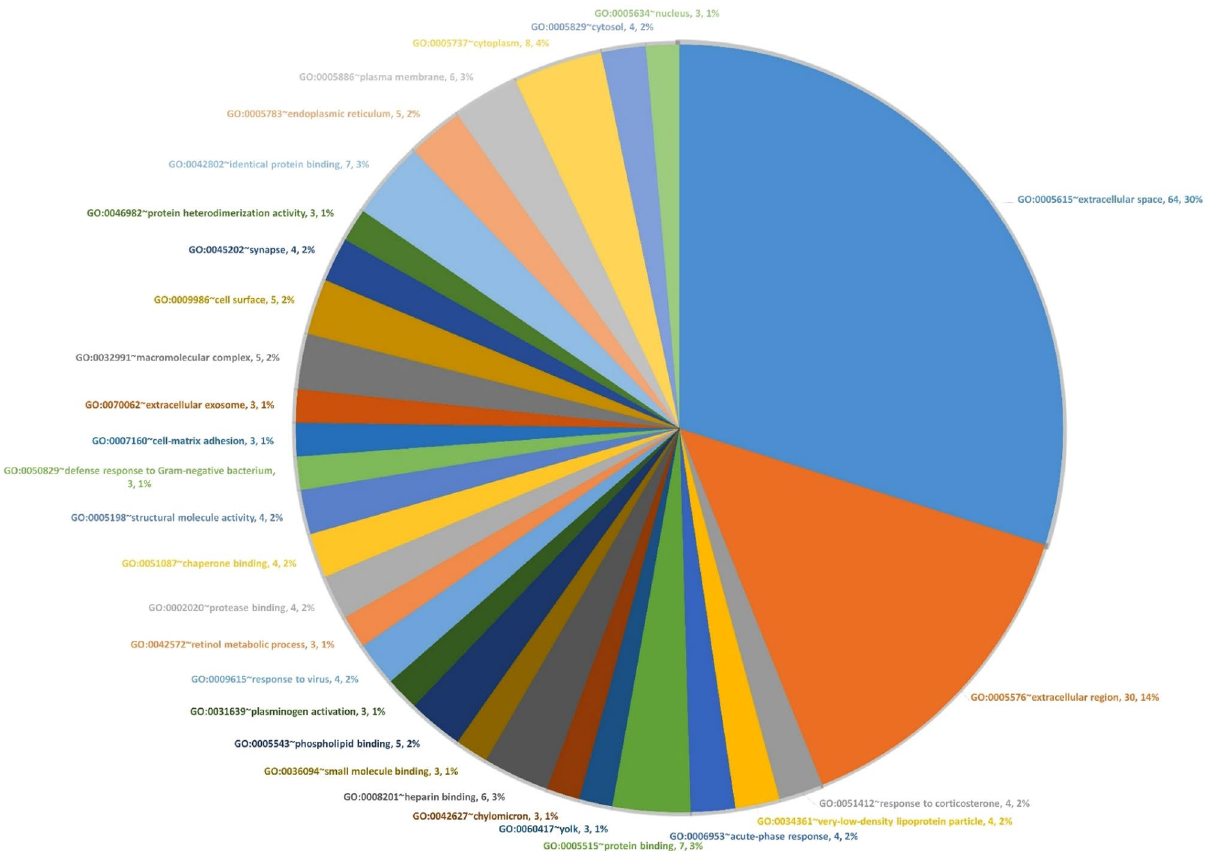
Figure 2. Gene ontology (protein count and percentage) and major functional processes of the proteins in VVs. Bioinformatics analysis showed involvement of VVs protein in different cellular compartments such as extracellular space, plasma membrane, exosomes, and other structural and metabolic processes.